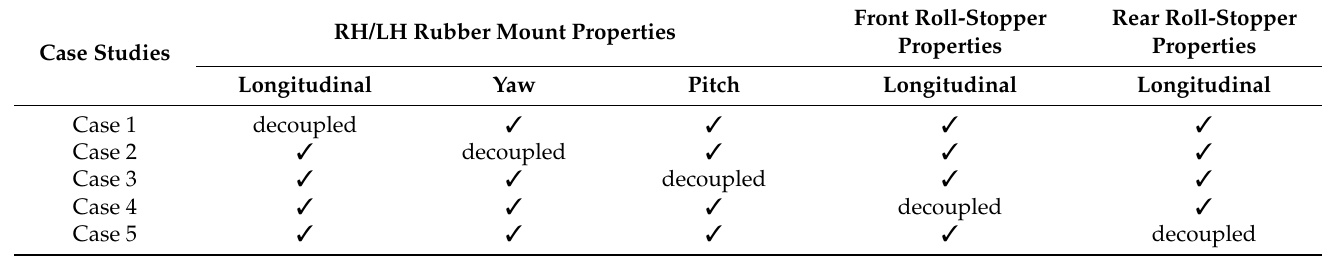
Front Roll-Stopper Rear Roll-Stopper Properties